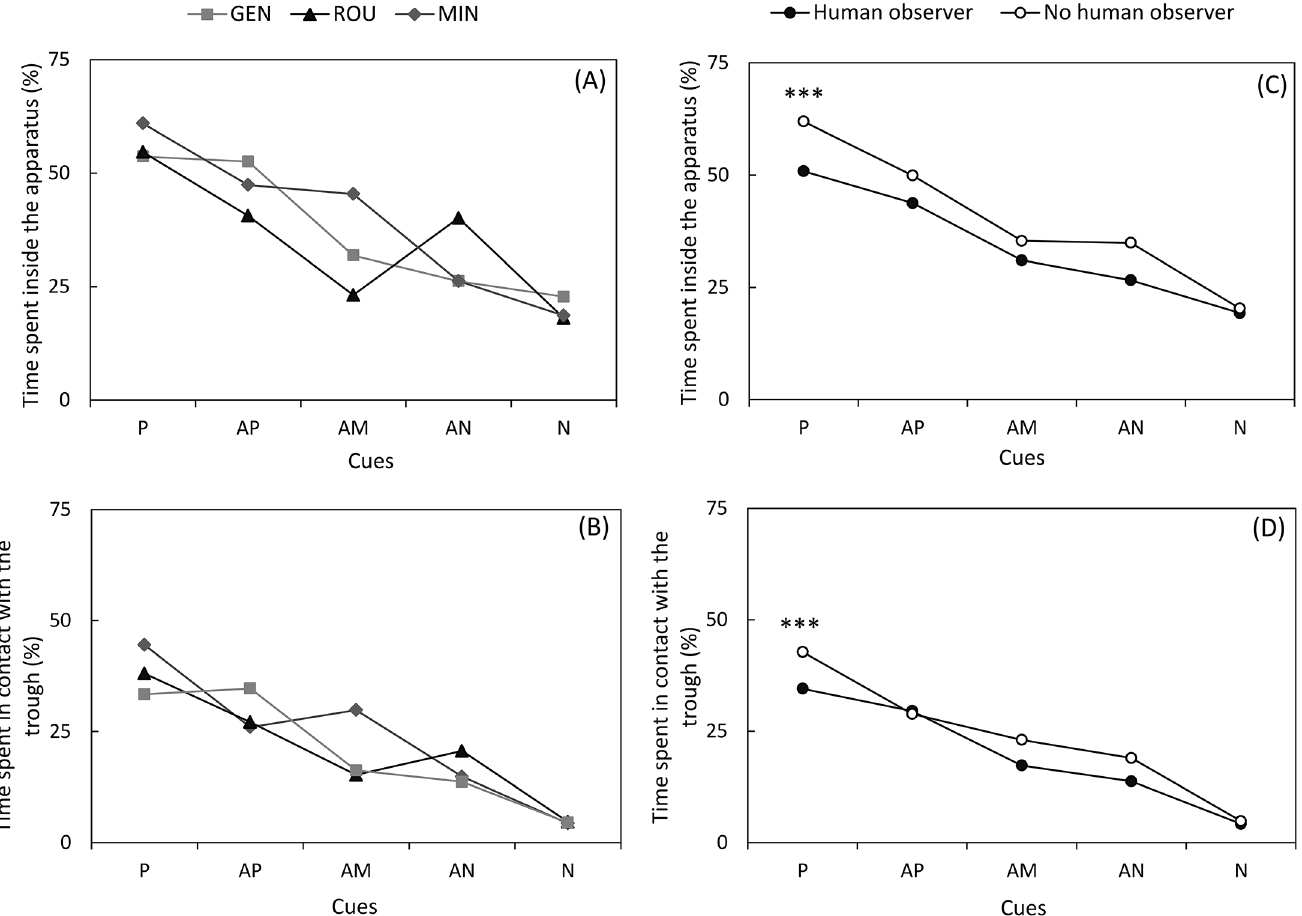
Fig 3. Percentages of time spent inside the apparatus and in contact with the trough are affected by the presence of a human observer, and to a lesser extent, by treatments. (A) Average percentage of time spent inside the apparatus and; (B) Average percentage of time spent in physical contact with the trough following playbacks of the five cues during cognitive bias tests for piglets from gentle (GEN, light grey squares), rough (ROU, black triangles) and minimal contact (MIN, dark grey diamonds) treatments, regardless of the presence or not of the handler; (C) Average percentage of time spent inside the apparatus and; (D) Average percentage of time spent in physical contact with the trough following playbacks of the five cues during cognitive bias tests in the absence (white circles) or presence (black circles) of the human observer, regardless of the treatment. (back-transformed least square means; P, positive cue; AP, ambiguous cue nearest positive cue; AM, ambiguous median cue; AN, ambiguous cue nearest negative cue; N, negative cue) ( *** P < 0.0001).